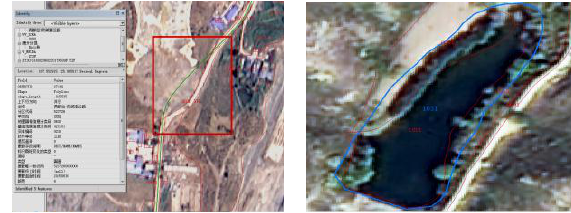
Figure 6. Lane error